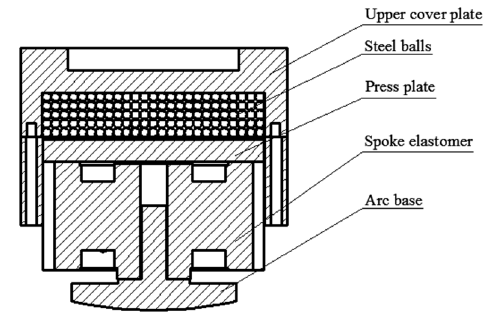
Figure 2. Schematic of particle damping sensor.